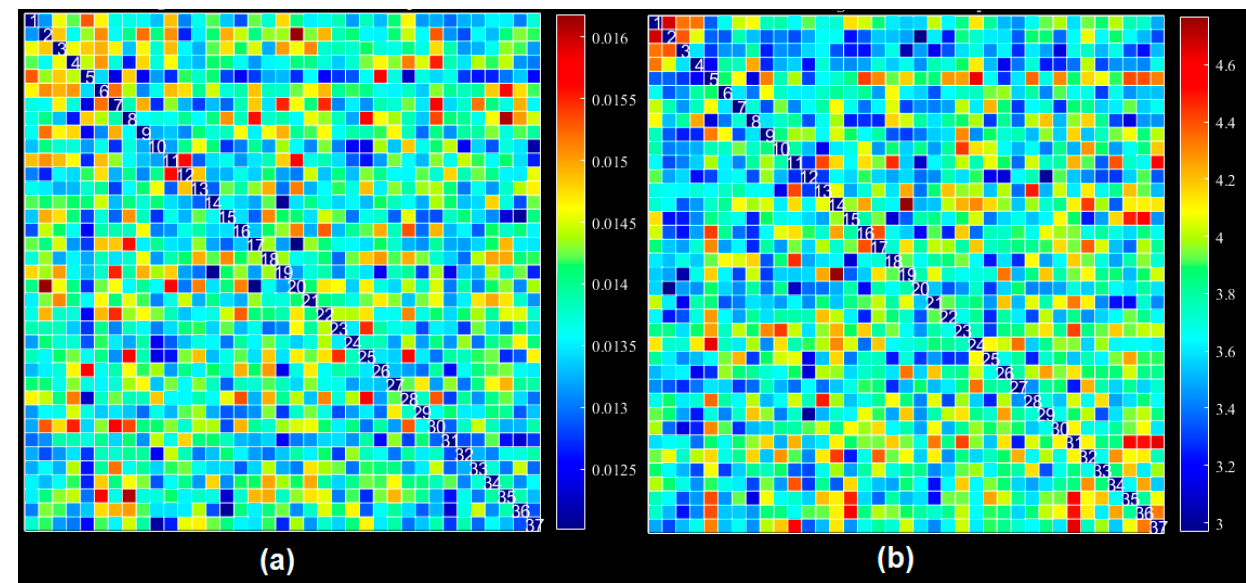
Figure 5. Dynamic functional connectivity using all extracted ICs: ( a ) average FNC across windows, ( b ) average standard deviation across windows for all datasets and averaged across subjects.